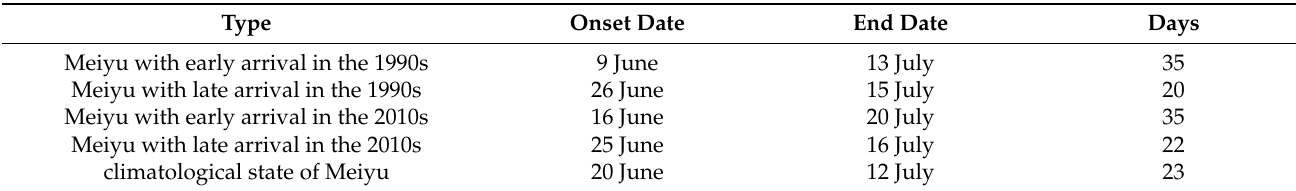
Table 1. Temporal characteristics of Meiyu in 1990s and 2010s.